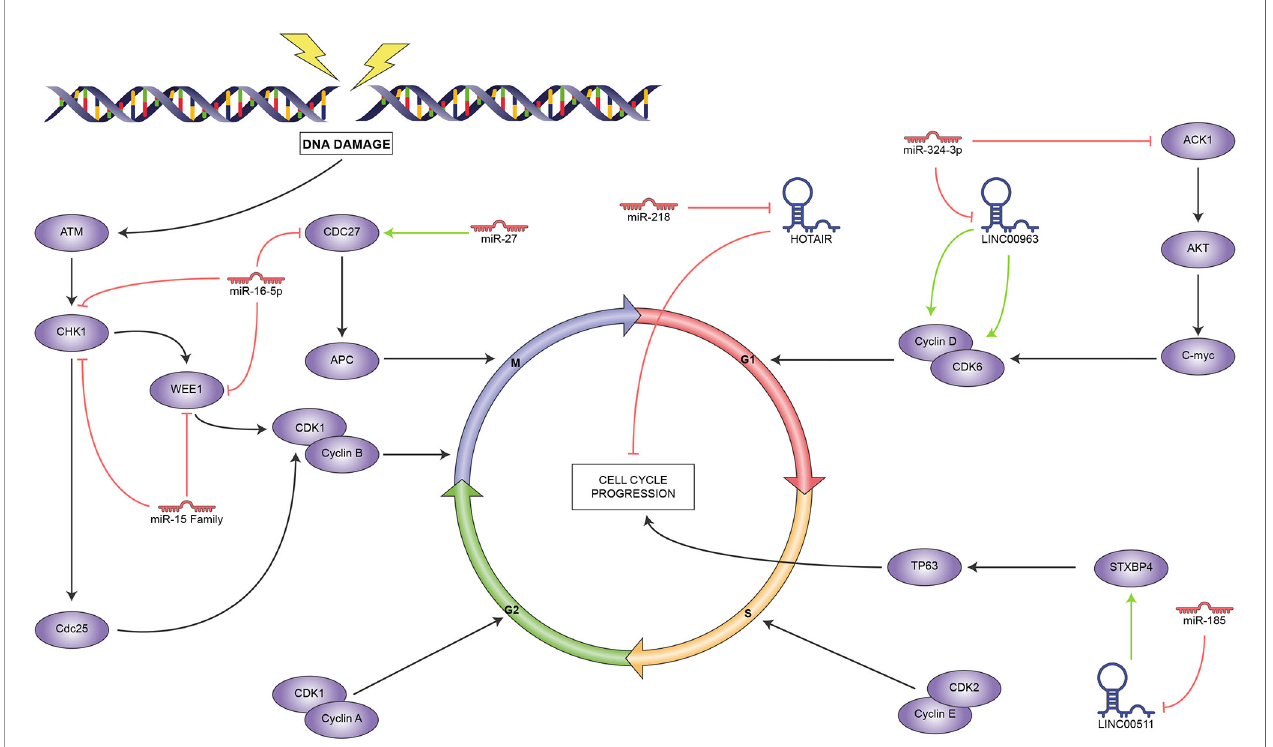
FIGURE 3 | Reported ncRNAs that regulate cell cycle and their targets. Green arrowheads represent positive regulation and red bars, negative